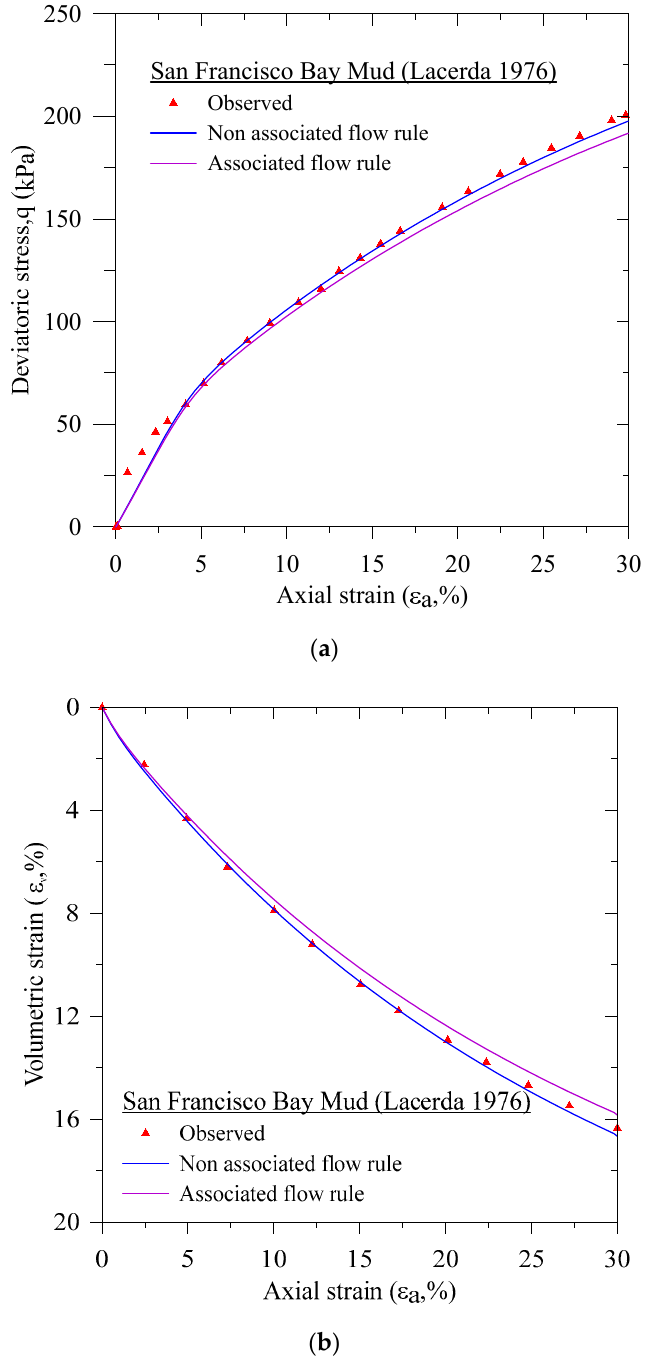
Figure 11. Comparison of the measured and the predicted consolidated drained triaxial compression tests on the San Francisco Bay Mud clay: ( a ) the deviatoric stress vs. the axial strain and ( b ) the volumetric strain vs. the axial strain.